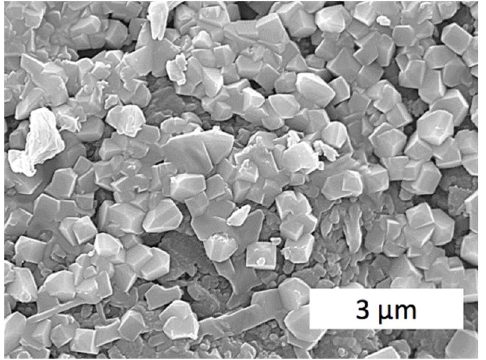
Figure 11. SEM image of the composite Al 2 O 3 —20 wt.% SiO 2 —10 wt.% ZrO 2 fracture. The electro- consolidation was performed at 1700 °С, under pressure 30 МPа during 3 min.